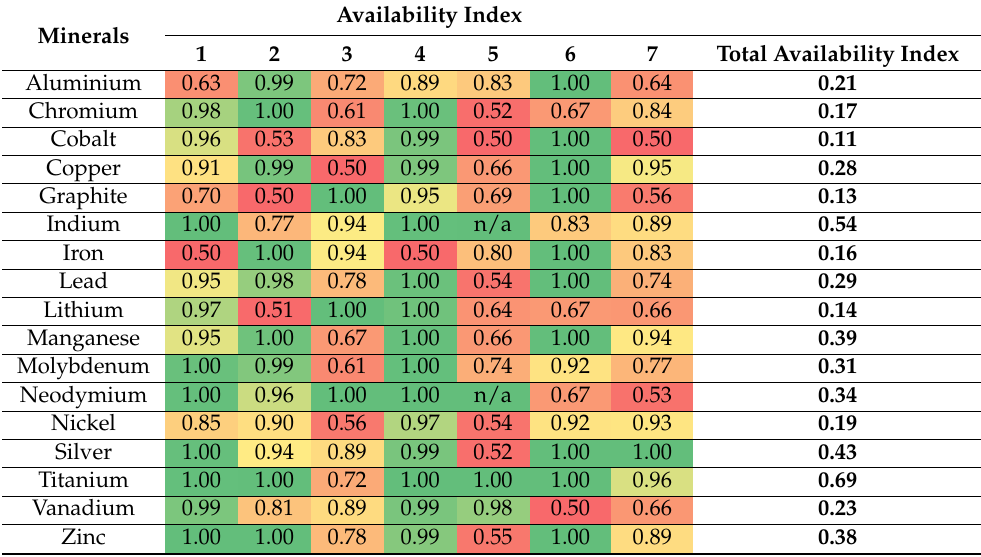
Figure 7. The spatial distribution of commodities with a significant annual production concentrated in each country. The total availability index was calculated as the product of the 7 defined indices (Appendix C, Tables A1–A7) and comprehensively took into account the risk of limited access to mineral reserves. The result is shown in Table 4, where green colour say about the full availability, red—About low one. Table 4. Total availability index by minerals.